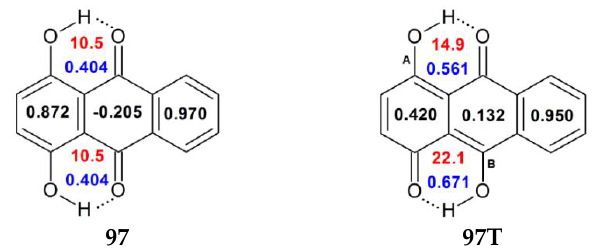
Figure 4. The transfer of aromaticity from ipso -ring to the enolic system. Values of quasiHOMA (in blue) and E HB (in red) were given in the centre of the hydrogen bonded ring, whereas the HOMA value was given in the ipso -ring.